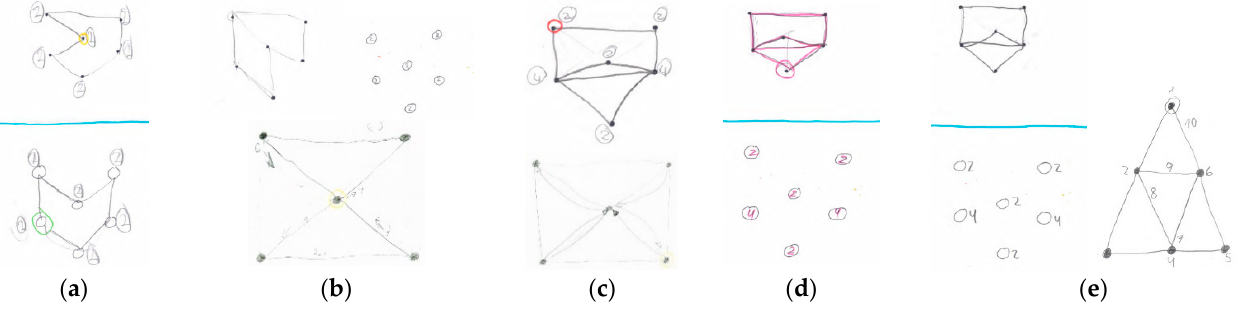
Figure 10. Tracing Eulerian cycles. Drawing made by participant: ( a ) A3; ( b ) A5; ( c ) A4; ( d ) A6; ( e ) A7.